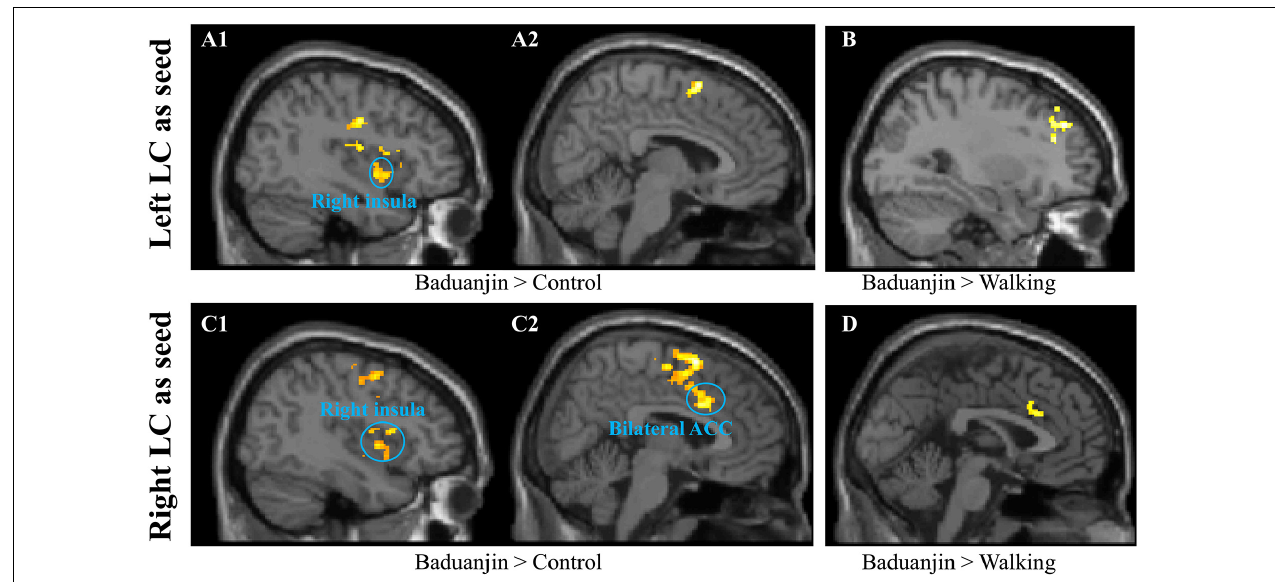
FIGURE 1 | Resting state functional connectivity results using the LC as the seed. (A1,A2,B) : using the left LC as the seed. (A1,A2) , Baduanjin > Control; (B) Baduanjin > Brisk Walking. (C1,C2,D) , using the right LC as the seed. (C1,C2) , Baduanjin > Control; (D) Baduanjin > Brisk